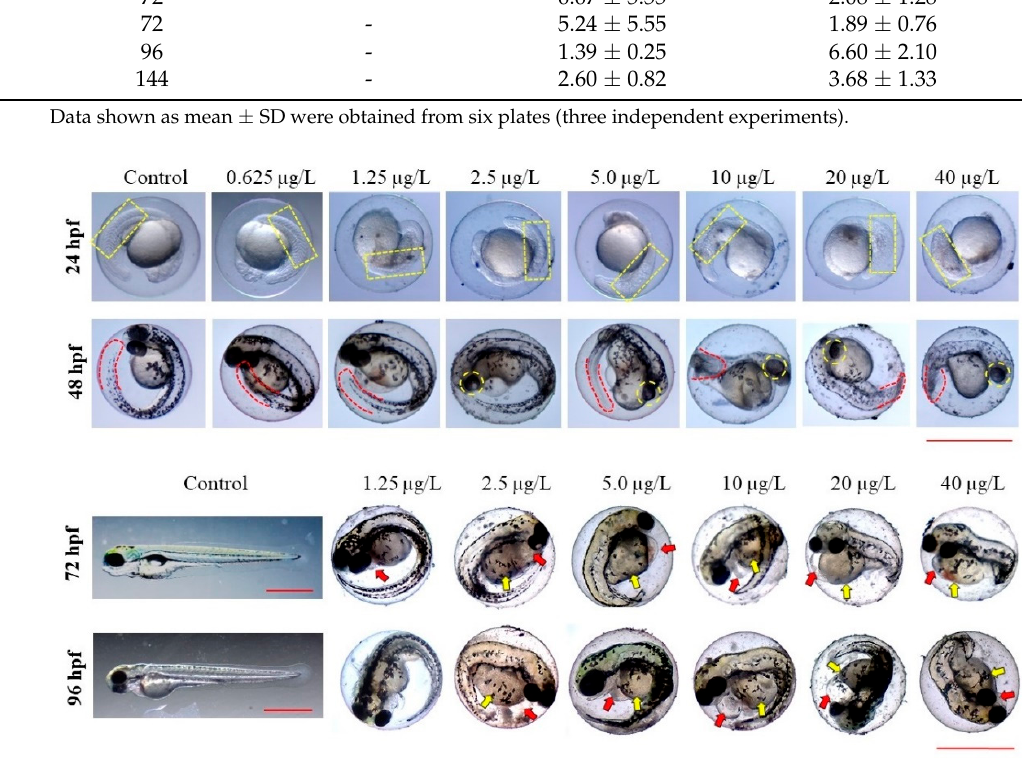
Figure 1. Representative images showing thiram-induced deformities at 24, 48, 72, and 96 hpf. Schemes follow the same formatting. Yellow dotted square: Somites; red dotted line: Shape of the tail; yellow dotted circle: Eyes; red arrow: Pericardial edema; yellow arrow: Yolk sac edema. Scale = 1.0 mm.